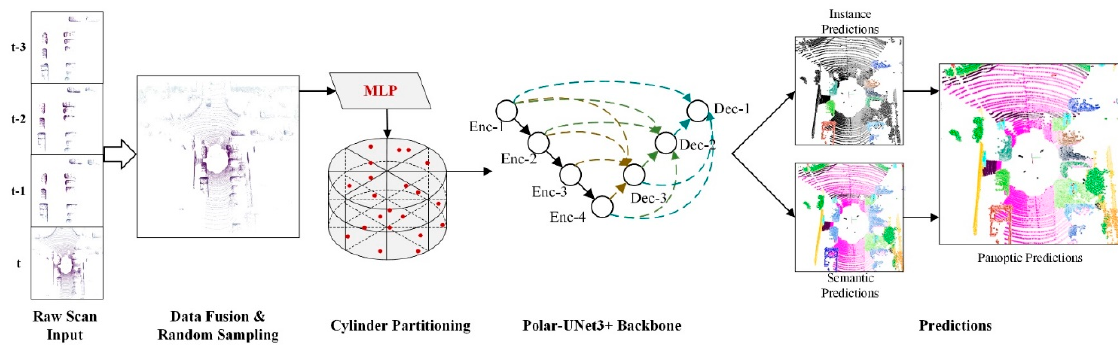
Figure 2. Overview of our proposed method. We first aligned “thing classes” point clouds together within the temporal window. After fusing them with the current scan, random sampling was performed as input (Section 3.2). Then, a network called Polar-UNet3+ (Section 3.4) was introduced, a strong backbone used for semantic segmentation and instance detection based on cylinder partitioning (Section 3.3). Finally, the panoptic prediction was obtained by fusing the above predictions.